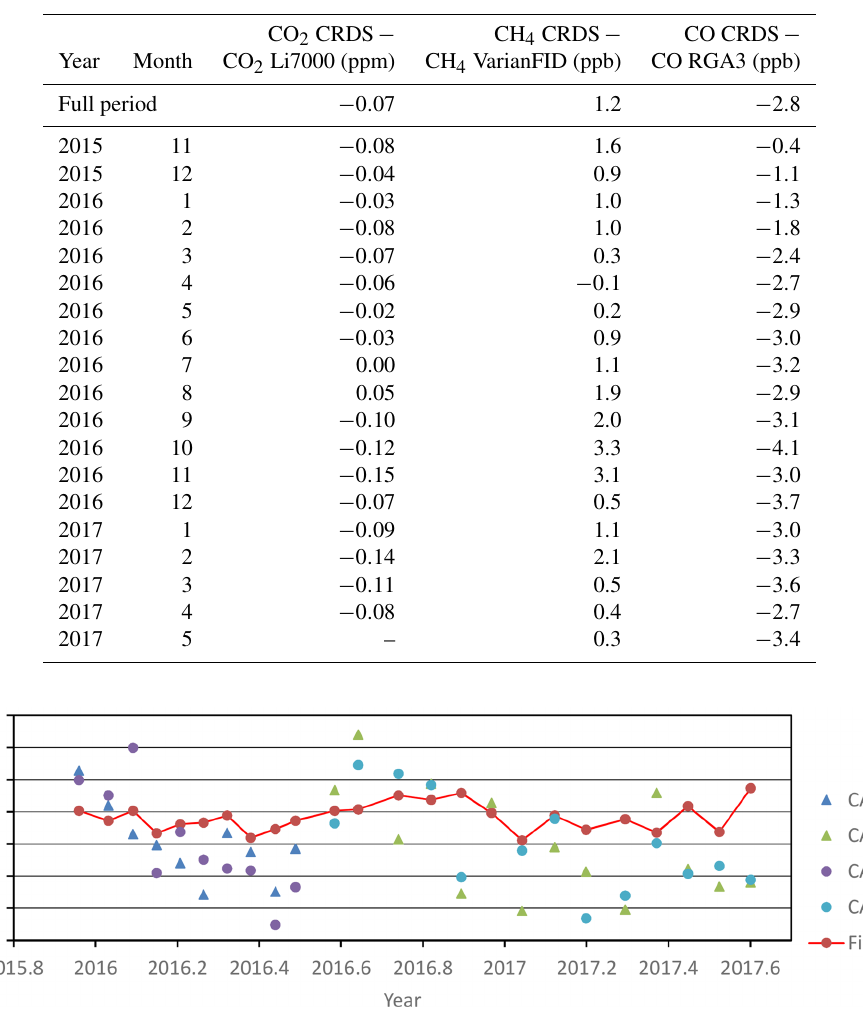
Table 7. Monthly-mean differences between the daily-nighttime CRDS measurements and those for the rest of the mentioned IZO instruments (Li7000 NDIR for CO 2 , Varian GC-FID for CH 4 , and RGA-3 GC-RGD for CO).